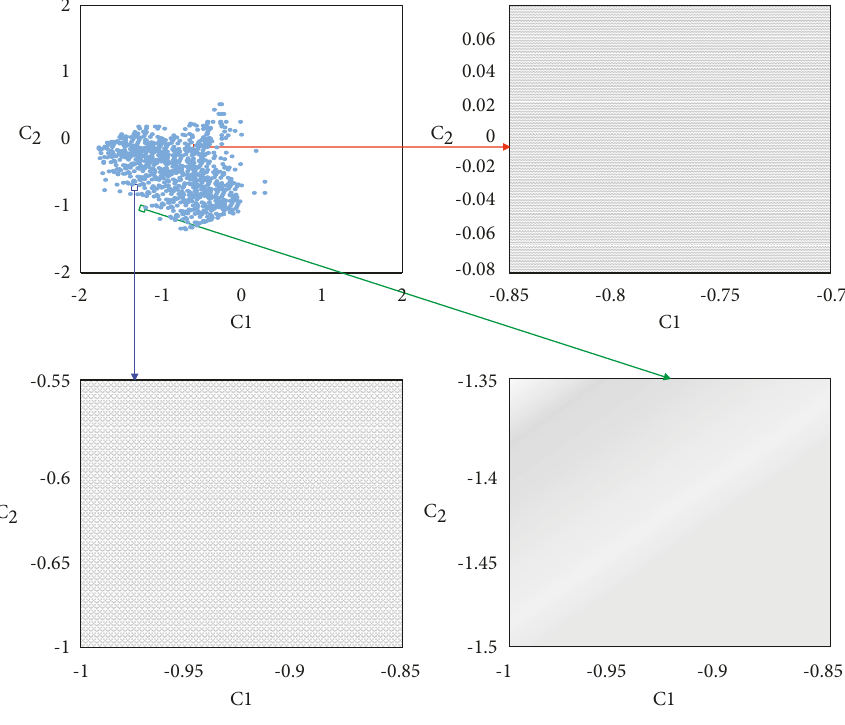
Figure 4: Three partial enlarged